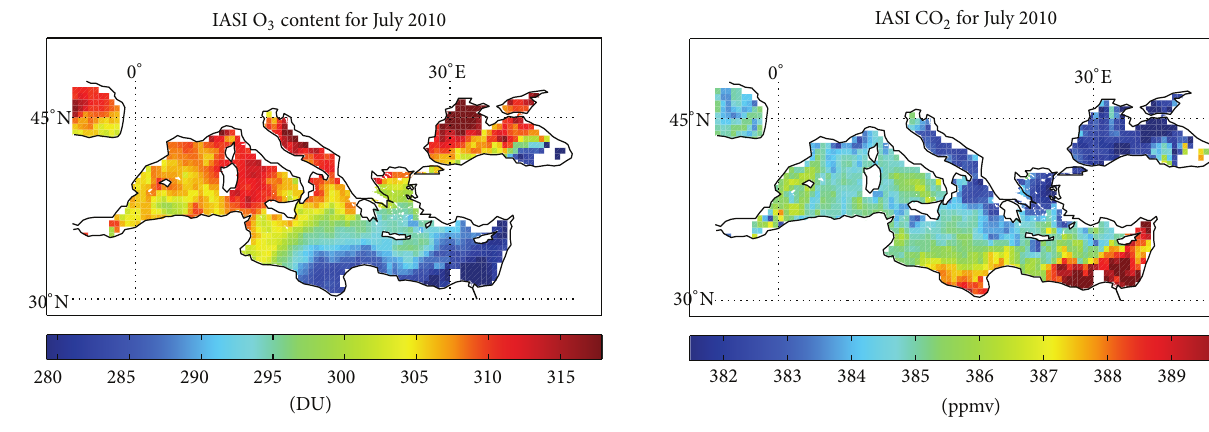
Figure 8: Retrieved tropospheric CO 2 content for the month of July 2010. Data have been smoothed and rendered on a grid of 0.5 ∘ × 0.5 ∘ (lat. × lon.).